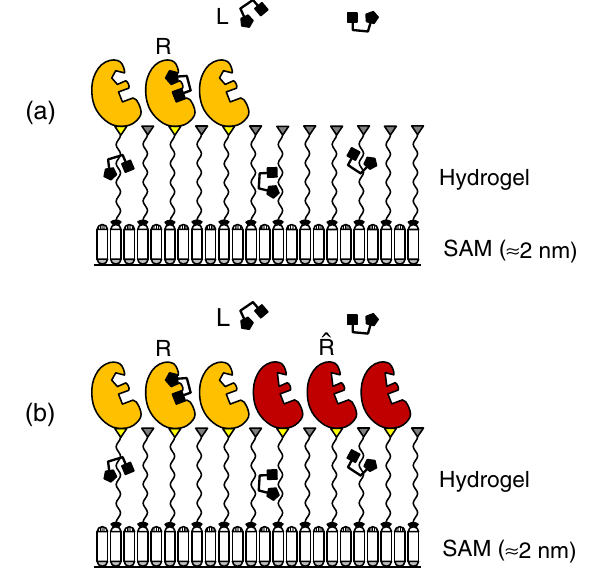
FIG. 4. Only one local period of the mologram consisting of one “ ridge ” and one “ groove ” is shown in Figs. 4(a) and 4(b). (a) Nonbackfilled mologram. (b) Backfilled mologram: The grooves between the receptor molecules R are filled with an ^ unreceptive (e.g., point-mutated) mimetic receptor R (red ^ ^ molecules). R does not recognize the ligand L; R is unreceptive ^ for L. L does not bind to R. (a),(b) The ligand L (black molecules) is recognized by the receptor R (yellow molecules) and binds to the receptor R. Ligand molecules that bind nonbiospecifically to the hydrogel or to the SAM on the sensor surface are homogeneously distributed across the sensor surface; these molecules do not contribute to the coherent signal in the focus of the